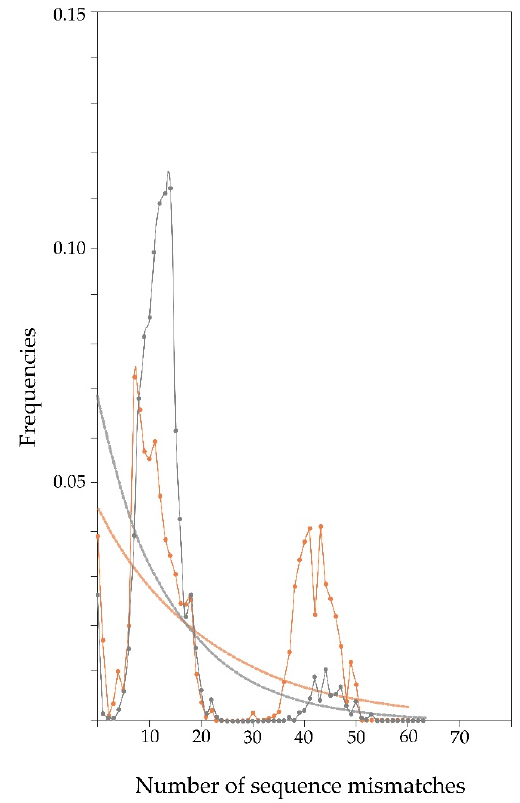
Figure 1. Frequency distribution of the number of sequence mismatches between pairwise combi- nations of Tsigai (gray) and Cikta (orange) mtDNA CR haplotypes.